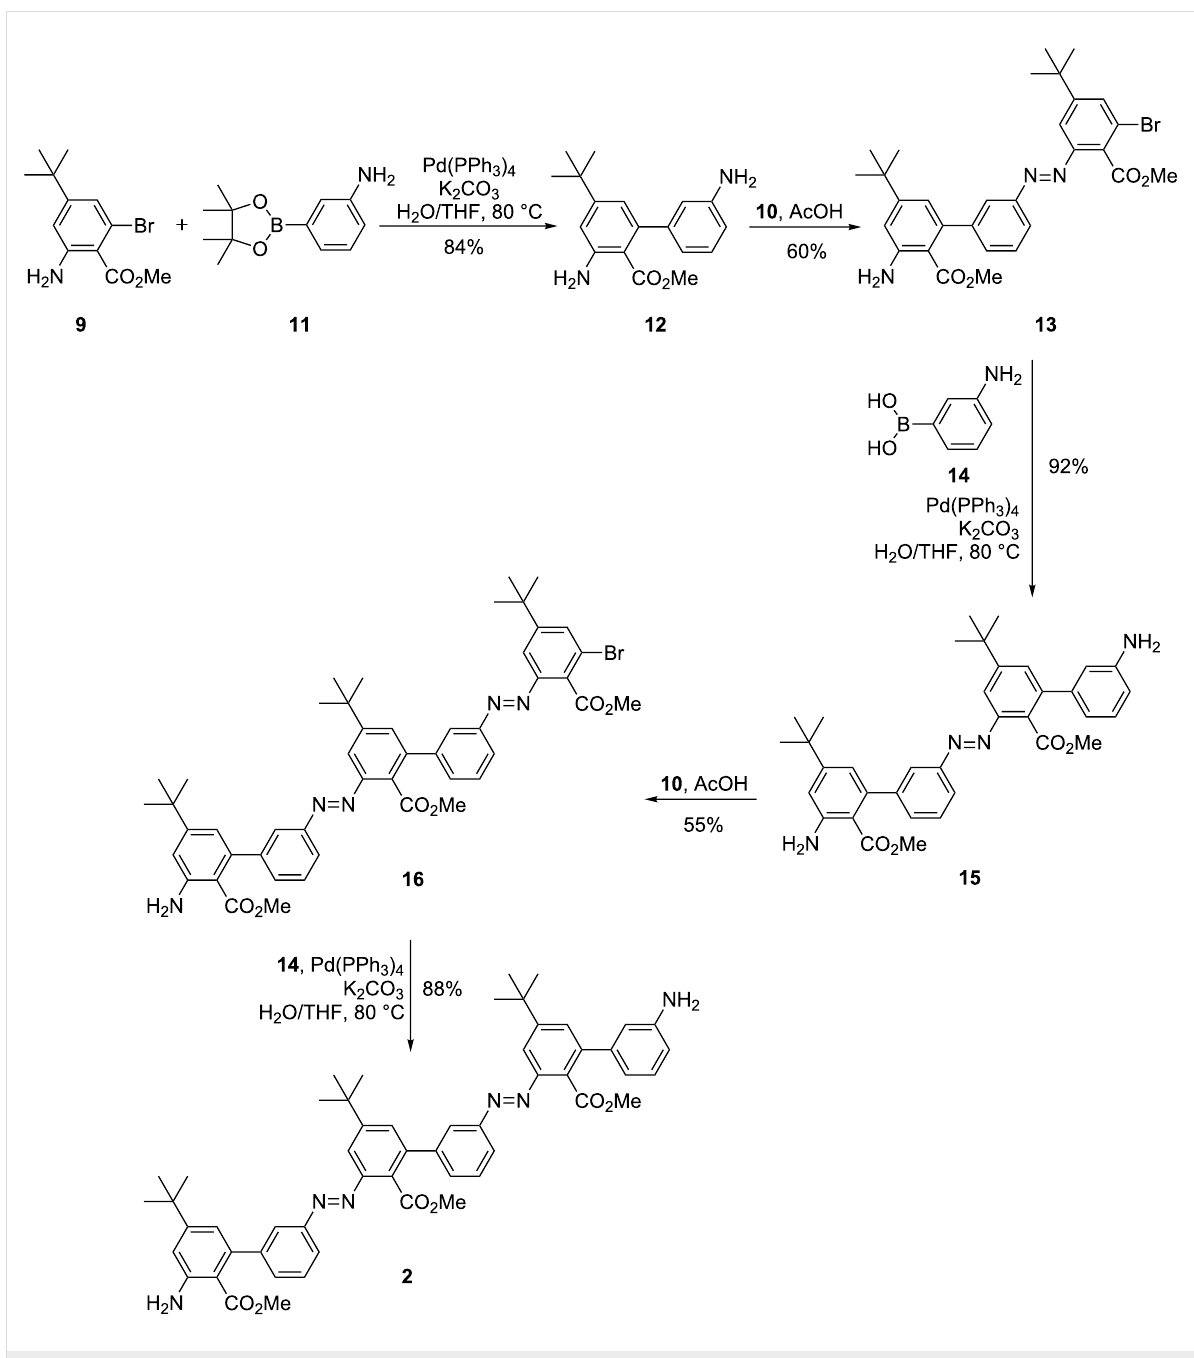
Scheme 3: Assembly of oligomer 2 by Suzuki cross-coupling and site-selective Mills reaction.